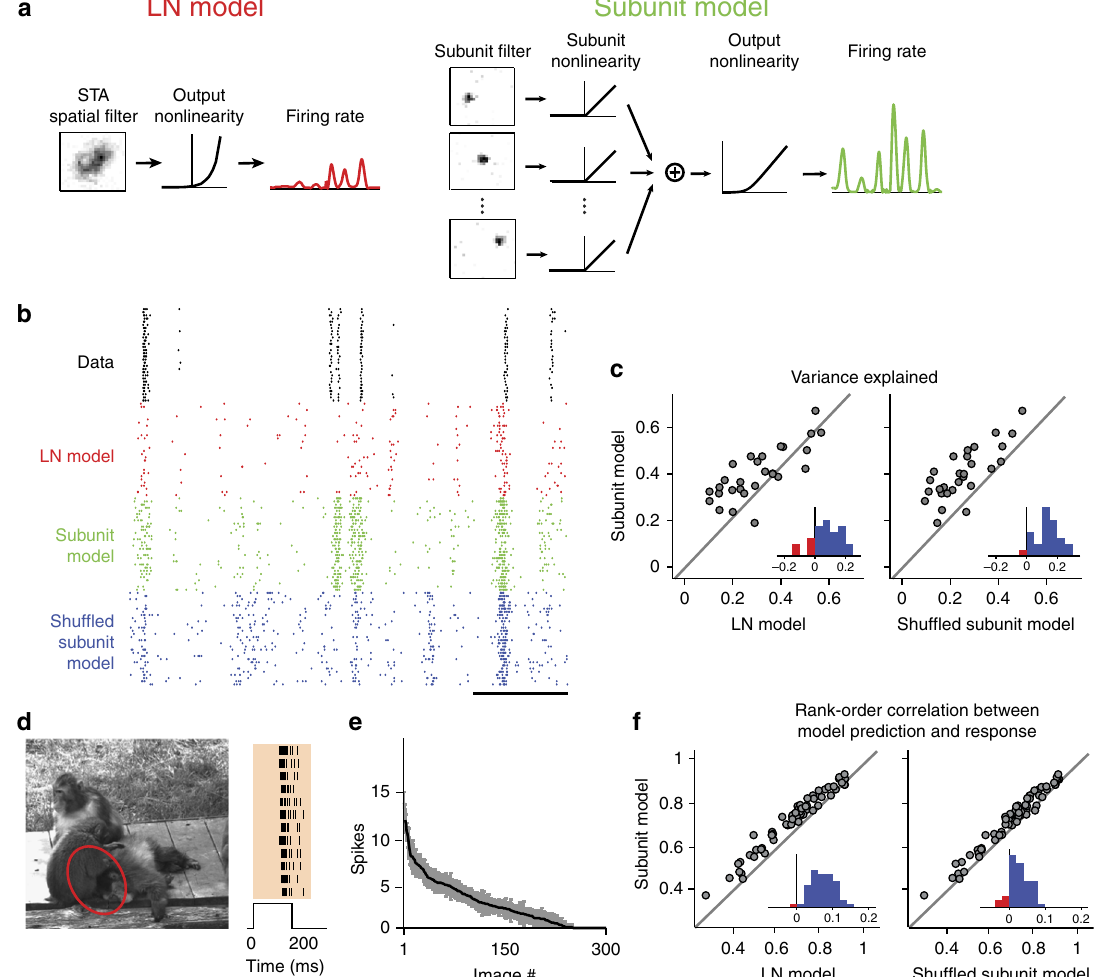
Fig. 4 Using subunits to predict ganglion cell responses. a Illustration of model structures for the linear-nonlinear (LN) model ( left ) and the subunit model ( right ). The subunit model takes each identi fi ed subunit as a spatial fi lter and then sums their outputs after recti fi cation. Both models pass the obtained fi lter signal through a fi nal output nonlinearity to predict the cell ’ s fi ring rate. b Raster plots of measured spikes and simulations of the fi tted models for a sample cell under frozen spatiotemporal white noise. Spikes were simulated by a Poisson process that takes the models ’ fi ring rates over 33-ms bins as input. Scale bar, 1 s. c Comparison of variance explained over the frozen-noise section for the different models. Each data point corresponds to a different ganglion cell ( N = 28 cells from one retina). Insets show histograms of differences in variance explained. The variance explained is signi fi cantly higher for the subunit model compared to the LN model ( p = 9 × 10 − 4 ; Wilcoxon signed-rank test) as well as compared to the shuf fl ed subunit model ( p = 1 × 10 − 5 ). d Sample image used to measure responses to brie fl y fl ashed natural images and corresponding measured spike responses from a sample ganglion cell for several stimulus repeats. The red ellipse shows the 3-sigma outline of the ganglion cell receptive fi eld. The shaded region in the raster plot shows the window over which spikes were counted. e Average spike counts ( black line ) and standard deviations ( grey region ) of the sample cell for each of the 300 images. f Comparison of rank-order correlations between predicted and measured responses for the different models. Each data point corresponds to a different ganglion cell ( N = 46 cells from six retinas). Insets show histograms of differences in rank-order correlation. Differences between the subunit model and the other two models are signi fi cant ( p < 10 − 6 in both cases; Wilcoxon signed-rank